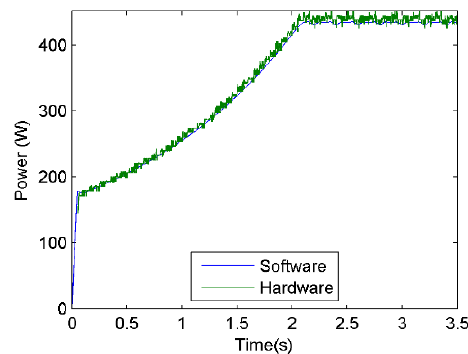
Figure 25. Response of the PVPE power with the MPPT controller emulator.